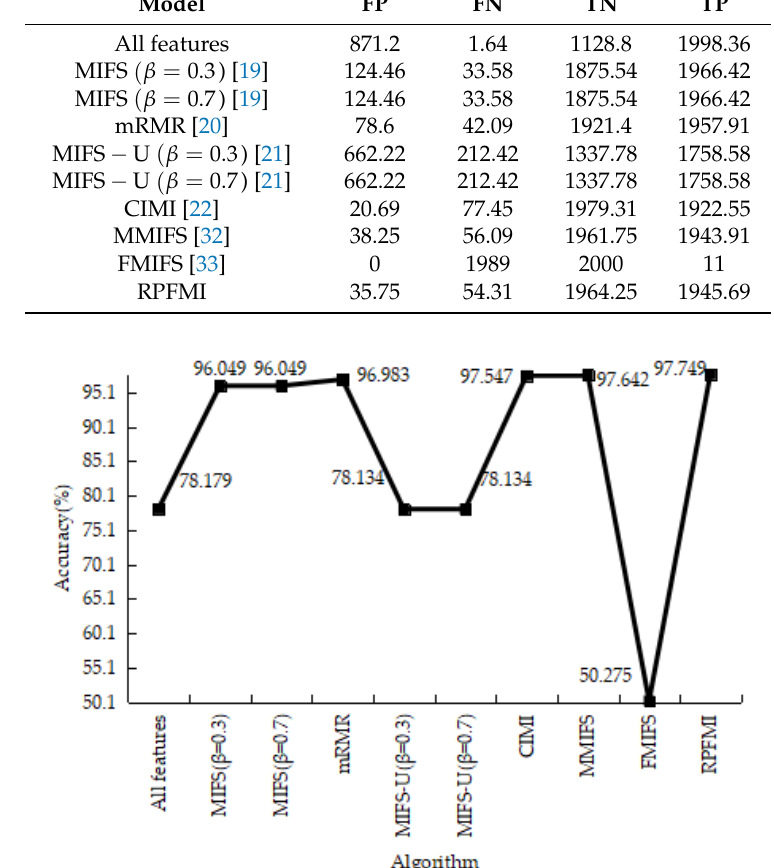
Table 12. Confusion matrices in different models using the Kyoto 2006+ test data.